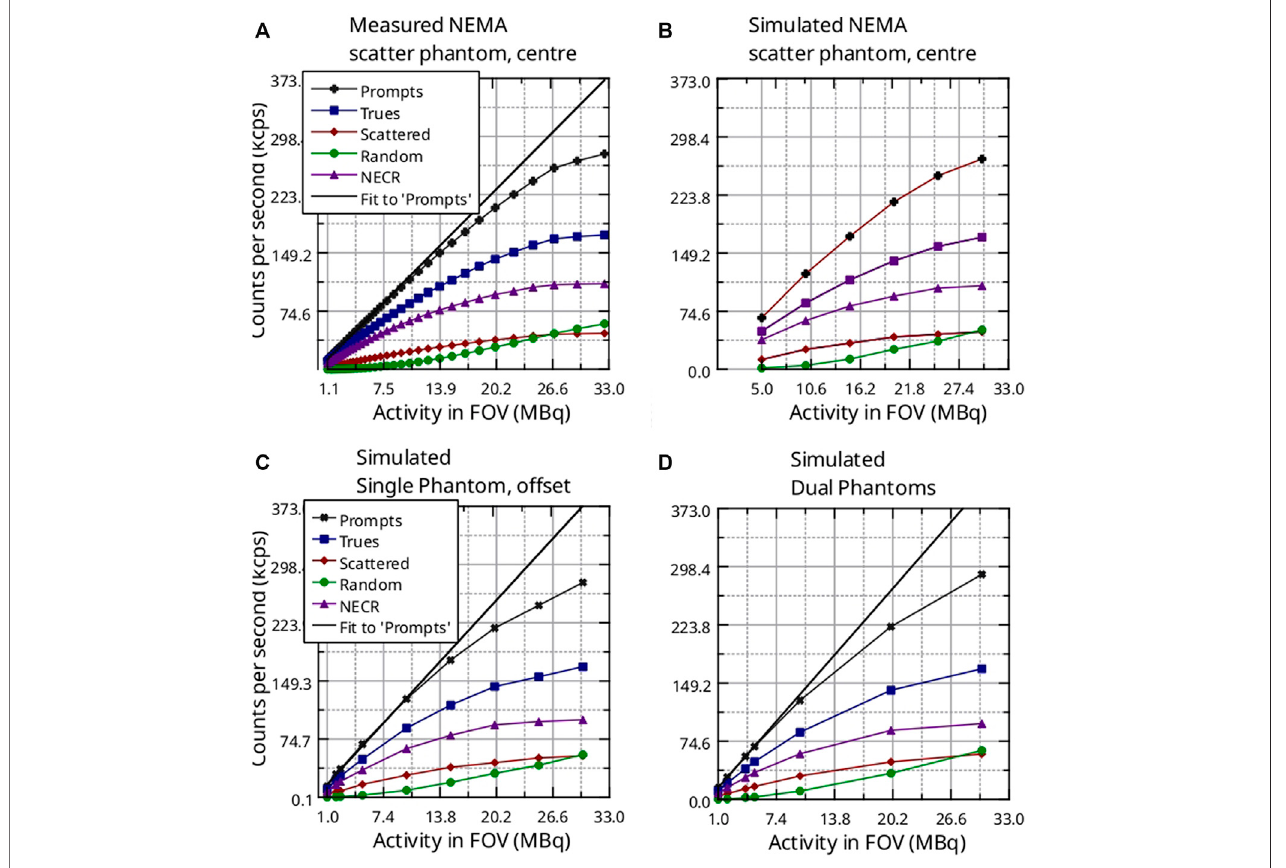
FIGURE 2 | Prompt, Trues, Random Scatter rates and NECR for the NEMA scatter phantom for (A) Experimental measurements at the central bed position. (B) Simulated central bed position. (C) Simulated off center, and (D) dual phantom scanning. The linear fi t to the Prompts was performed for the fi rst fi ve points.